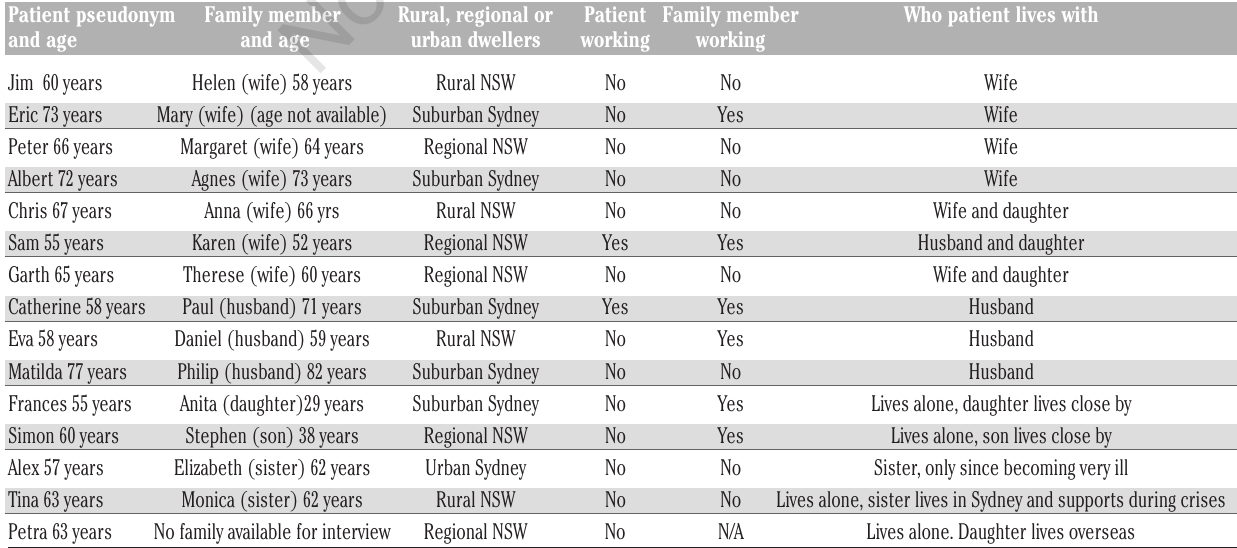
Table 1. Characteristics of